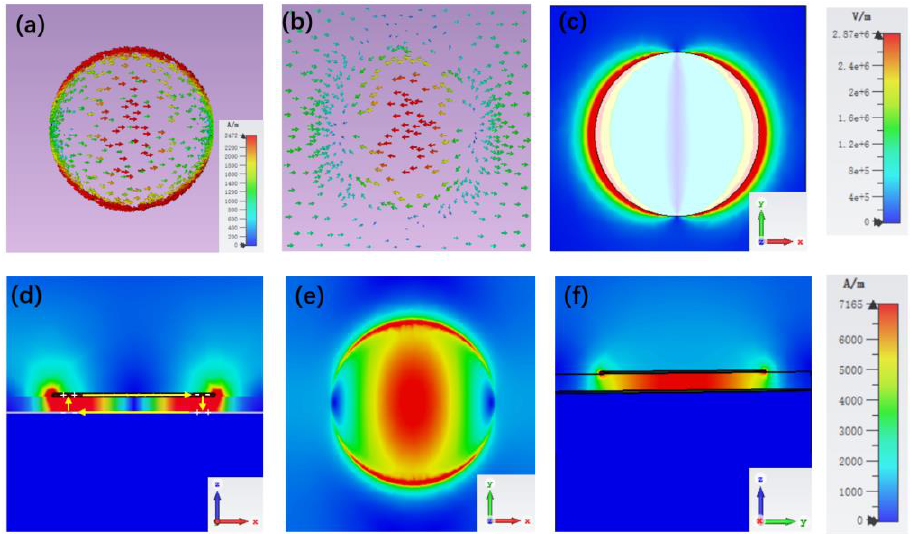
Figure 6. Distributions of the surface current of ( a ) the top metal layer and ( b ) the middle metal layer. Distributions of ( c ) the electric field in the x–y plane, ( d ) the electric field in the x–z plane, ( e ) the magnetic field in the x–y plane, and ( f ) the magnetic field in the y–z plane of the unit-cell structure in the proposed PMMA at 2.426 THz at a temperature of 280 K.